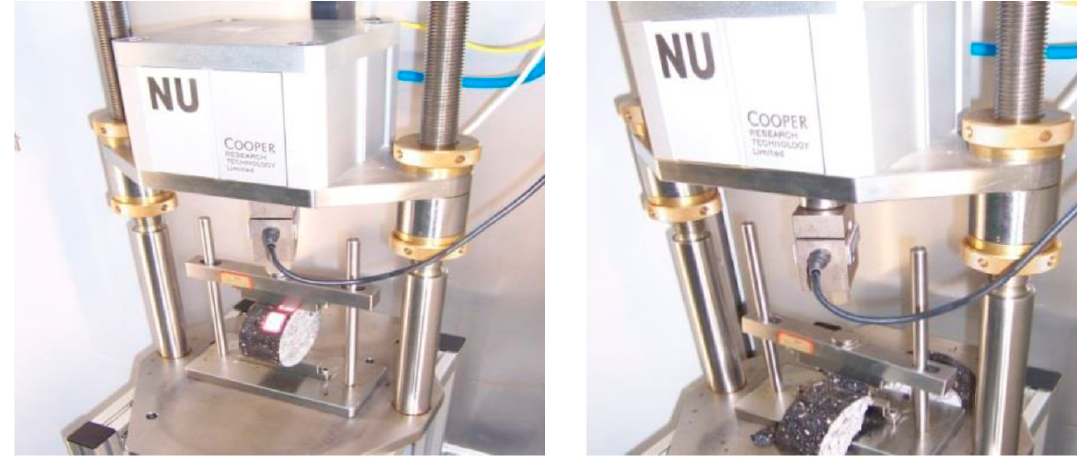
Figure 10. Indirect tensile fatigue test of NS RA-modified asphalt mixture.